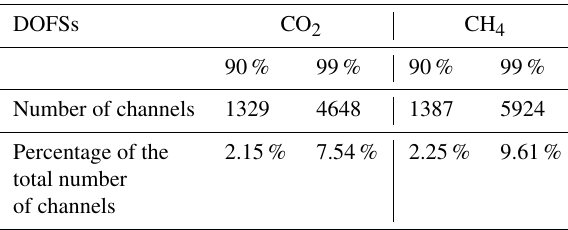
Table 6. Corresponding number of selected channels for the DOFSs of CO 2 and CH 4 and their respective percentage of the total number of channels for